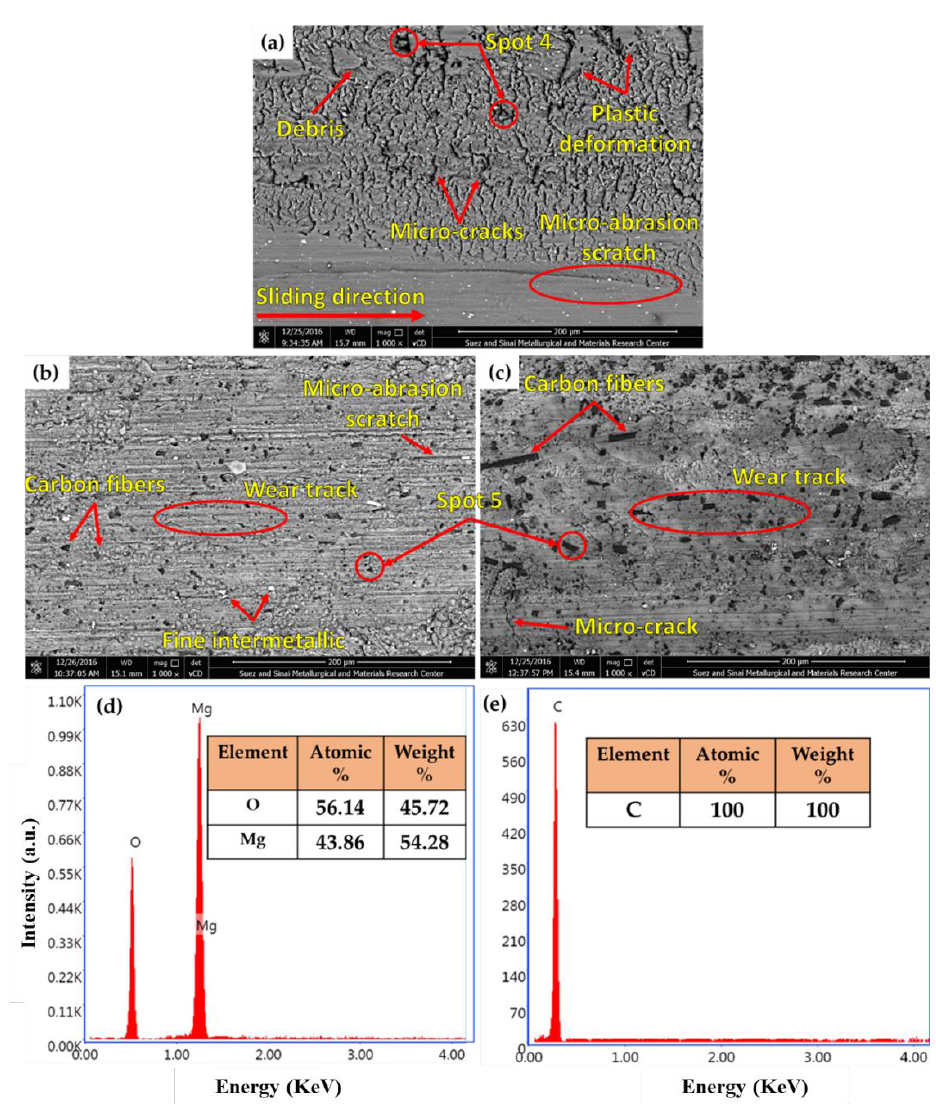
Figure 11. Worn surface SEM images of the ( a ) AZ91 matrix, ( b ) parallel composite, and ( c ) normal composite specimens at the applied wear load of 5 N, and a constant sliding distance of 1.34 × 10 4 m. Additionally, the EDS spot analysis of ( d ) MgO; (spot 4 in a ) and ( e ) carbon fibers; C (spot 5 in b , c ) is shown.